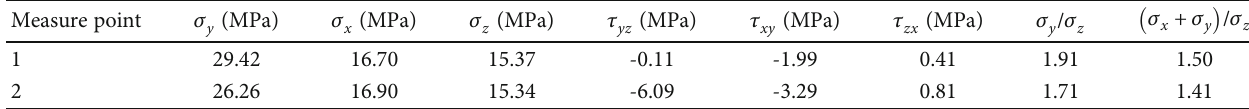
Table 2: Analysis of ground stress component